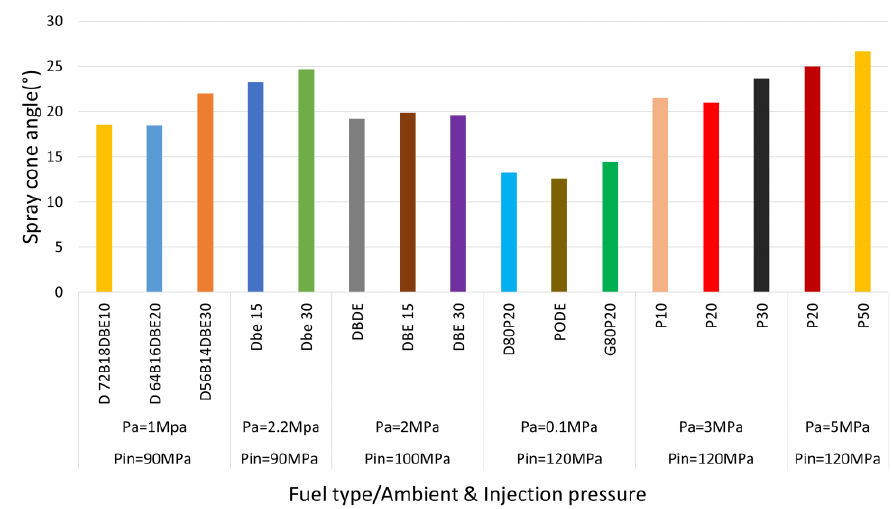
Figure 7. PL for various ether-based additives (such as DBE, PODE) with diesel at various injection & ambient pressure [30,74 – 77].